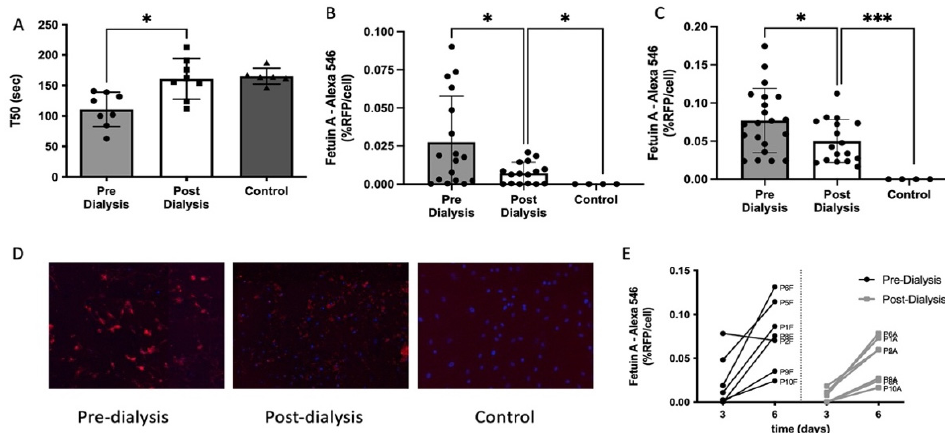
Figure 2. hVSMC calcification of CKD5D serum. ( A ) Serum from pre- ( n = 8) and post-dialysis ( n = 8) as well as control samples ( n = 6) were tested in the T50 assay; a significant difference was found between dialysis, but no difference between post-dialysis and control serum. ( B ) Effect of dialysis on hVSMC calcification at day 3. A significant increase in calcification was found in serum of pre-dialysis ( n = 7) vs. post-dialysis ( n = 7). ( C ) Effect of dialysis on hVSMC calcification at day 6. A significant increase in calcification was found in serum pre-dialysis ( n = 7) vs. post-dialysis ( n = 7). ( D ) Representative images (4x magnification) of the calcification assay, control vs. pre- and post-dialysis CKD5D serum. ( E ) The effect of dialysis on the in vitro calcification rate. Serum of pre-dialysis has a significant higher calcification rate as compared to the same individual post-dialysis. * p < 0.05; *** p < 0.001 .